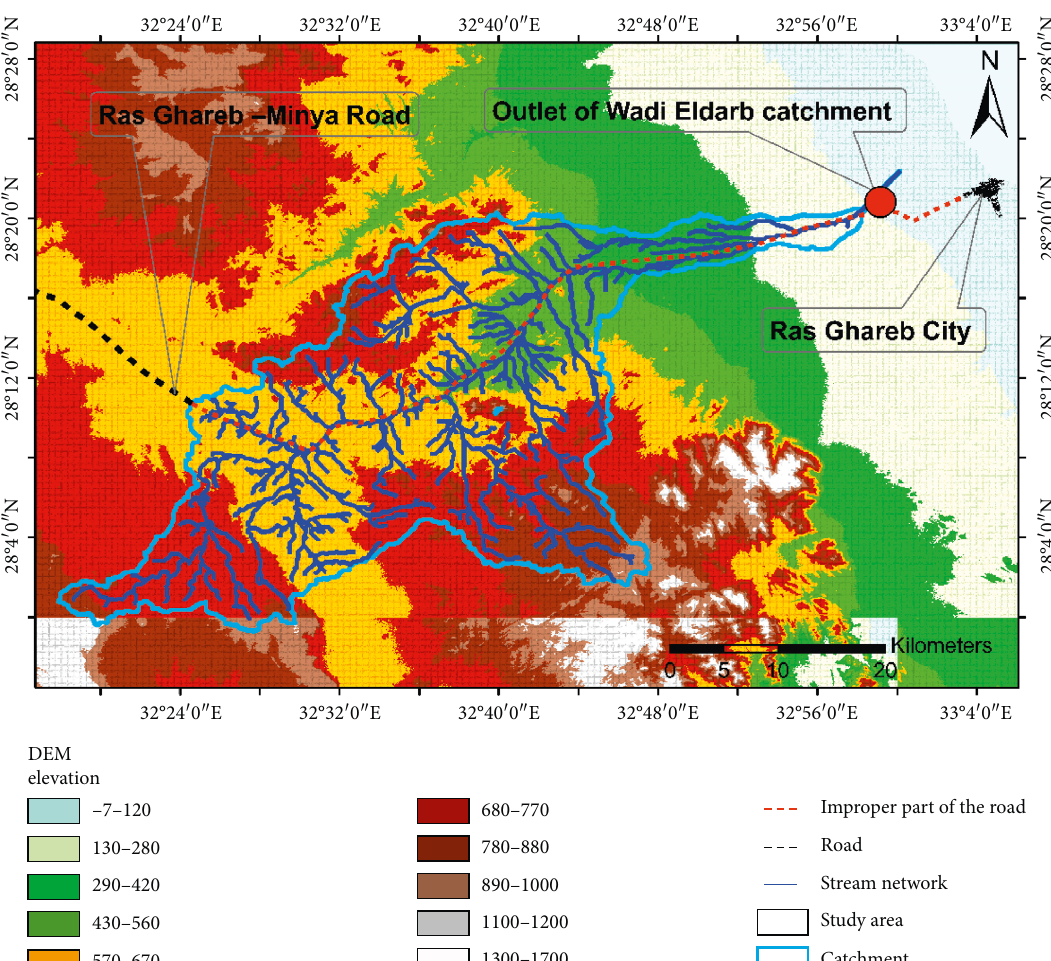
Figure 2: Wadi Eldarb catchment area which directly influences Ras Ghareb city. The geometric path of Ras Ghareb–Minya Road caused in transferring massive quantity of water to Ras Ghareb city presented in red